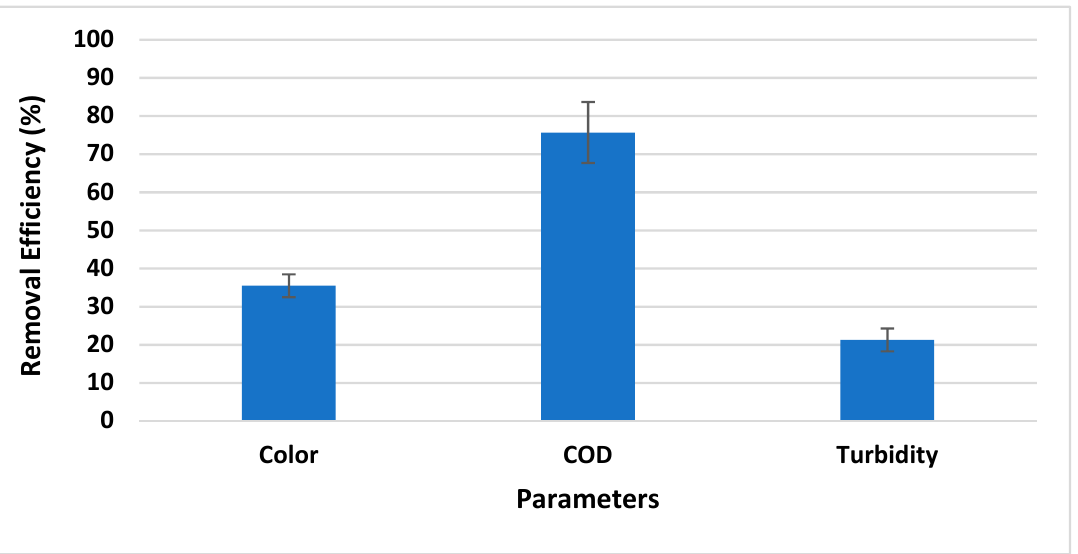
Figure 8. Fenton oxidation of chemically treated wastewater for removal of color, COD and turbidity. Means values are presented with standard deviation.